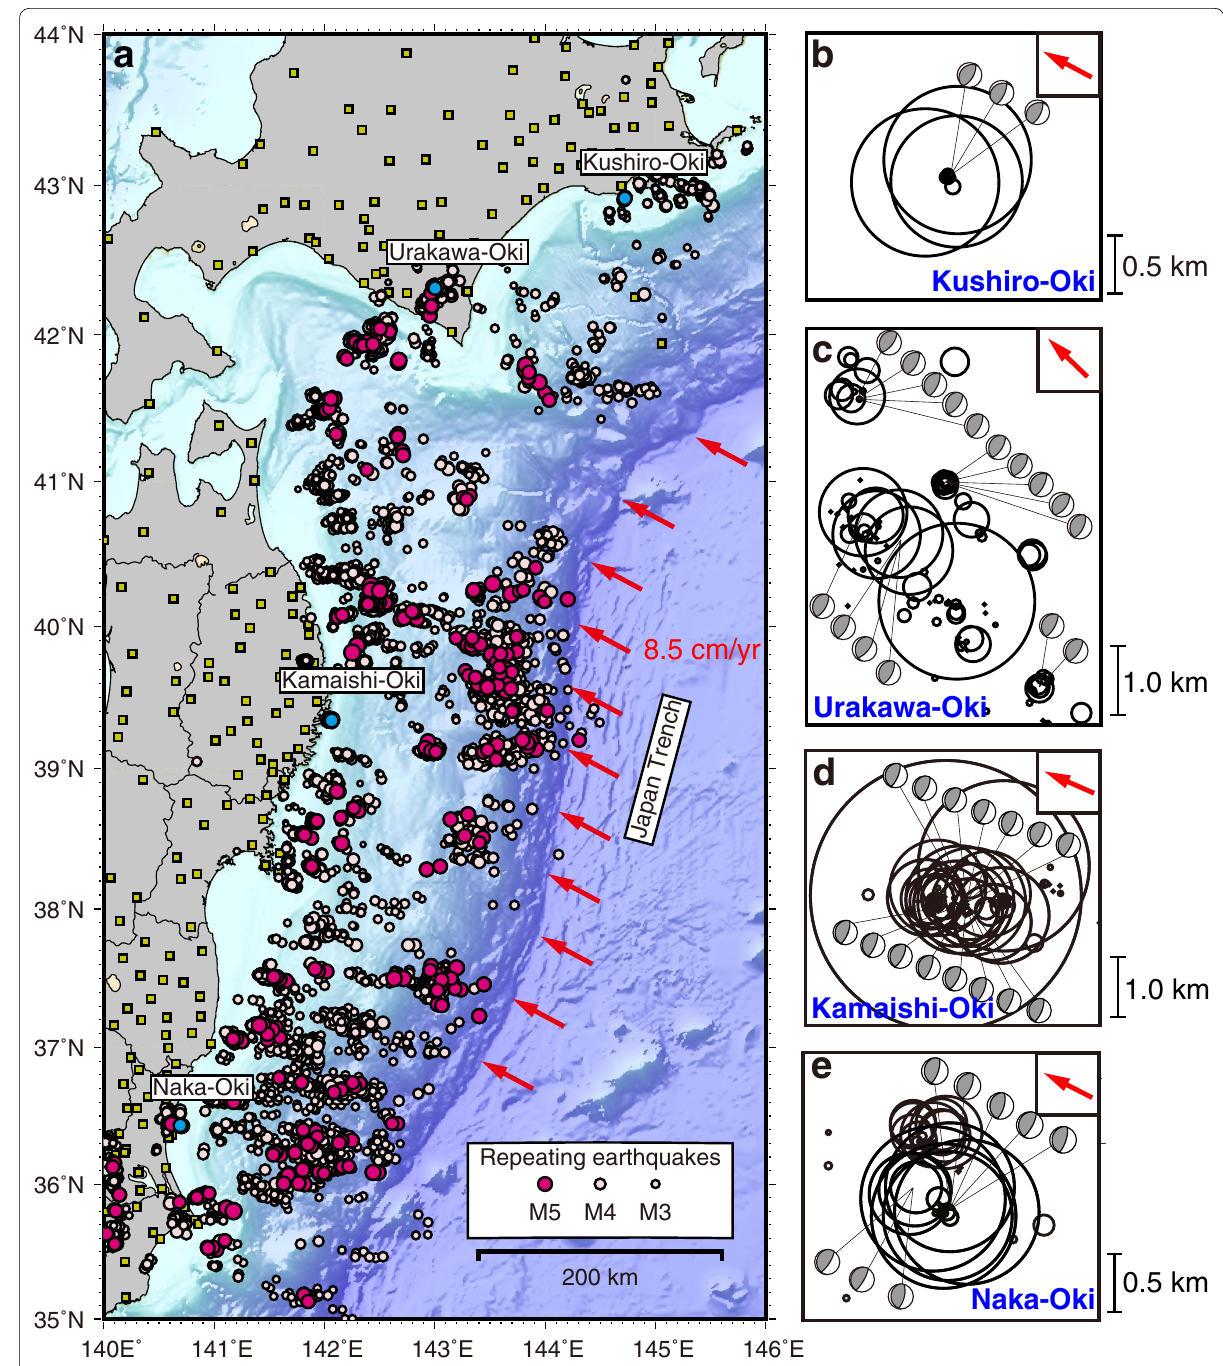
Fig. 1 Moderate-size repeating earthquakes in the Tohoku–Hokkaido subduction zone. a Locations of repeating earthquakes. The magenta circles show repeating earthquakes (Uchida and Matsuzawa 2013), and cyan circles indicate the four studied repeating earthquake sequences. The yellow squares show the stations used in the relocation analysis. b – e Centroid locations (circles) for the repeating earthquakes in the Kushiro-Oki ( b ), Urakawa-Oki ( c ), Kamaishi-Oki ( d ), and Naka-Oki ( e ) regions, with the radius of each circle representing the expected source size. The beach balls give the focal mechanisms of selected events. The red arrows indicate the averaged slip direction that was determined from the focal mechanisms in each